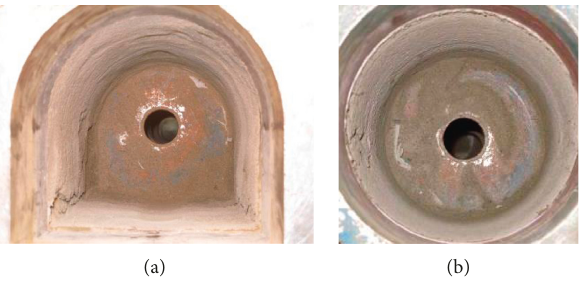
Figure 15: Destruction the interior wall of tunnels with different cross-sectional shapes after excavation in the physical model test. (a) The horseshoe tunnel. (b) The circular tunnel.